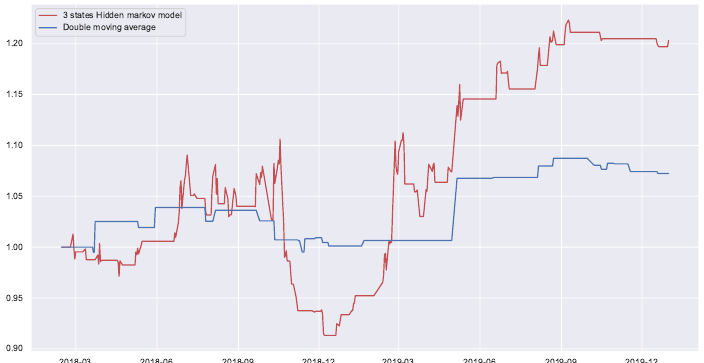
Figure 7. Comparison of the yield index curve of the three hidden states hidden Markov situation estimation trading strategy and the double moving average strategy.